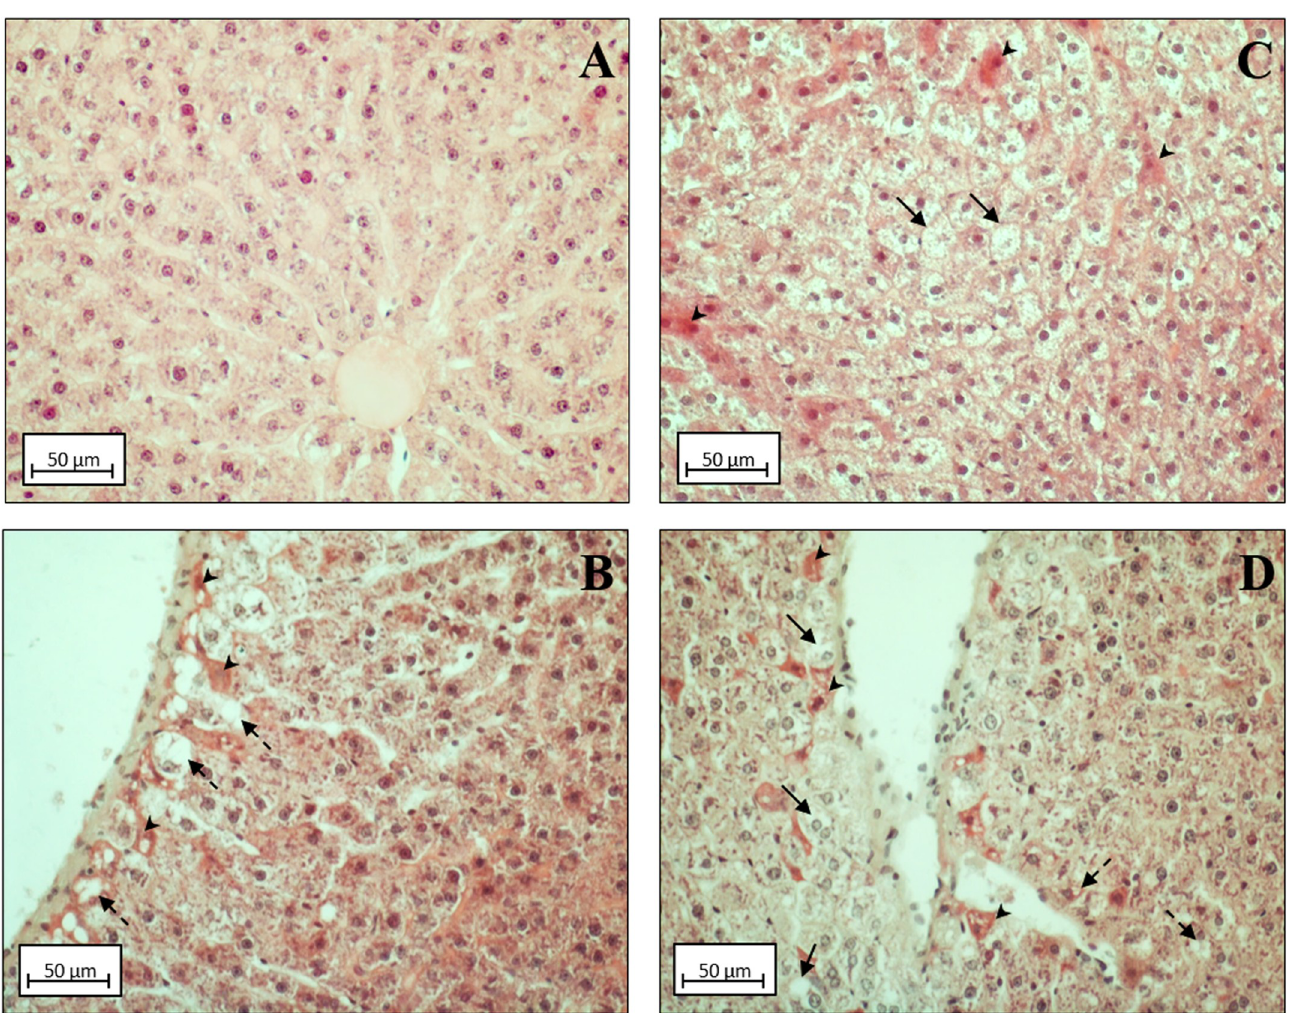
Fig 2. Liver histology. Sections of liver stained with Hematoxylin and Eosin. A) Control rats (N group). Lipid accumulation in HFD condition (black arrows, panel C, D group). Perivasal cellular vacuolization in presence of DDE (dashed arrows, panels B (N+DDE) and D (D+DDE). Eosinophilic cells in HFD (panel C) and in DDE-treated animals (panel B, N+DDE & panel D, D+DDE) were evidenced (arrowheads). Magnification used: 10X; Scale bar 50 μ m.